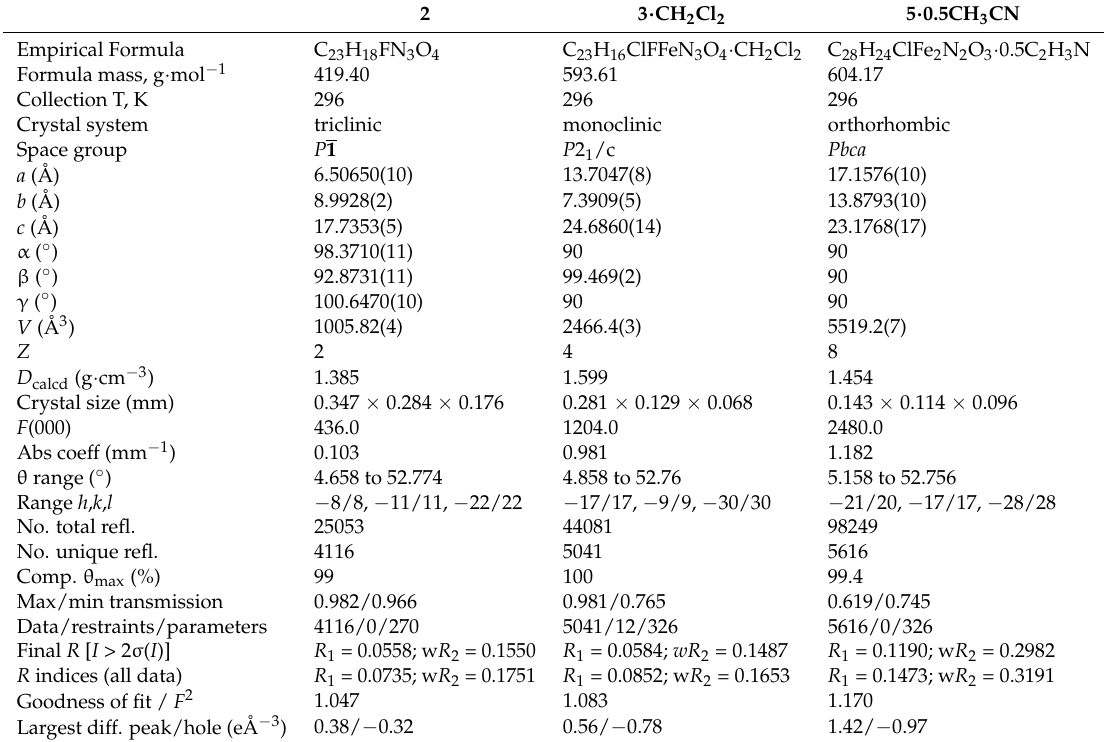
Table 4. Crystal data, details of data collection and structure refinement parameters for compounds 2 , 3 · CH 2 Cl 2 and 5 · 0.5CH 3